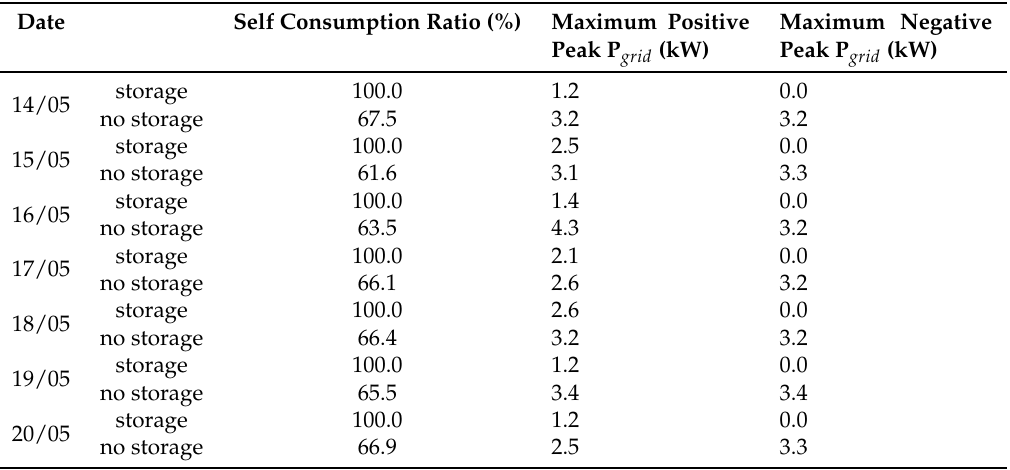
Table 6. Comparison between demonstrator results with and without